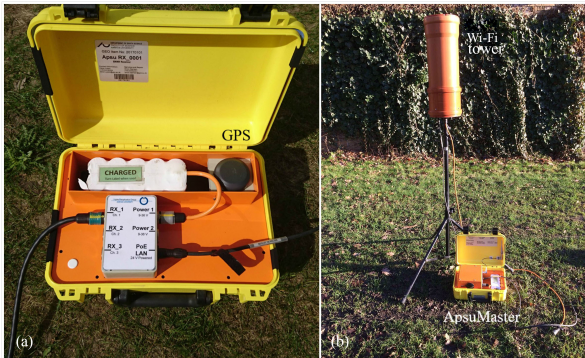
Figure 4. (a) ApsuRx. The breakout box of ApsuRx provides plugs for three signal inputs, power, and Wi-Fi antenna connection. The GPS antenna in the top-right corner is used for time synchroniza- tion. (b) ApsuMaster is connected to the Wi-Fi tower which consists of a array of Wi-Fi antennas working in the access point